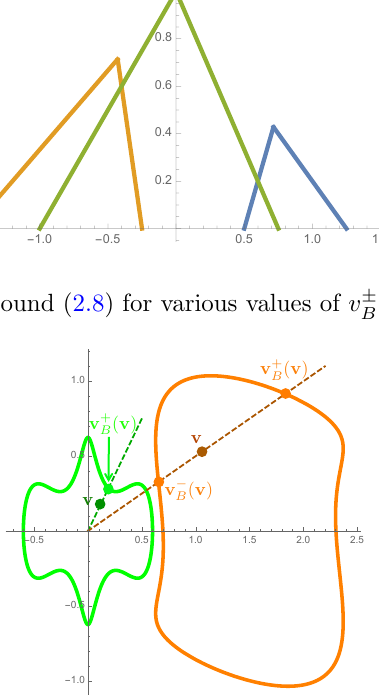
( v ) is de(cid:12)ned. For the orange B